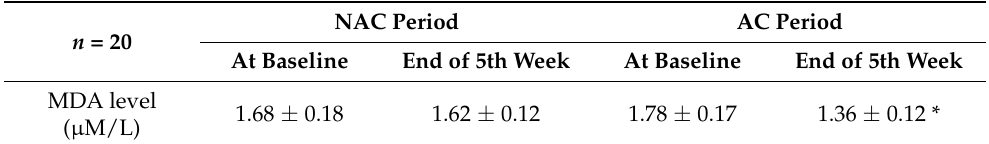
Table 2 . Serum MDA levels in tracheal collapse dogs ( n = 20 ) at the beginning and the end of NAC Table 2. Serum MDA levels in tracheal collapse dogs ( n = 20) at the beginning and the end of NAC and AC period . and AC period.